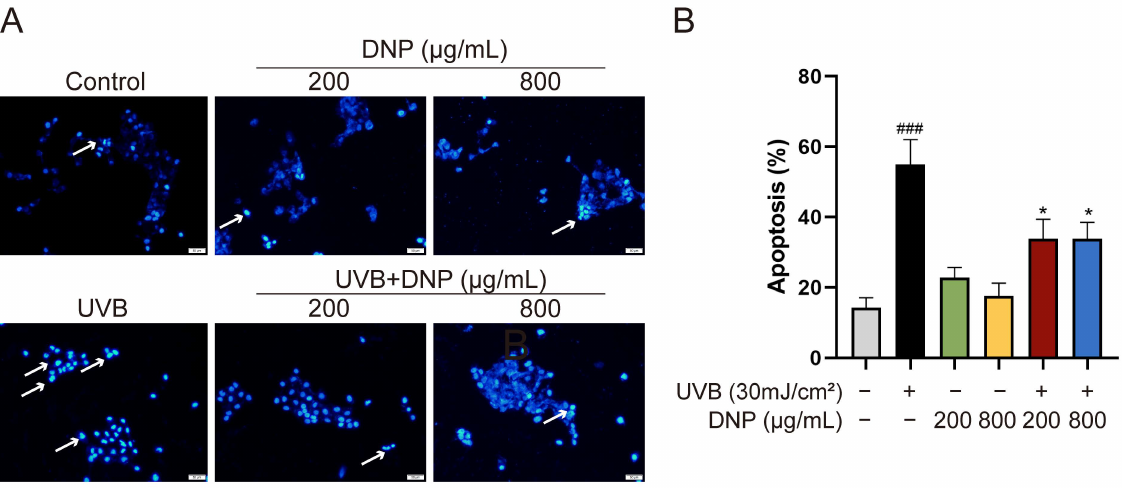
Figure 7. DNPs inhibit UVB-induced apoptosis of cells. ( A ) Representative images of Hoechst 33258 staining. The blue region indicates cell nuclei, and white arrows indicate the apoptotic cells with distinct features, such as intense fluorescence and presence of apoptotic bodies. Scale bar = 50 µ m. ( B ) Quantification of apoptosis. ### p < 0.001 vs. control group; * p < 0.05 vs. UVB